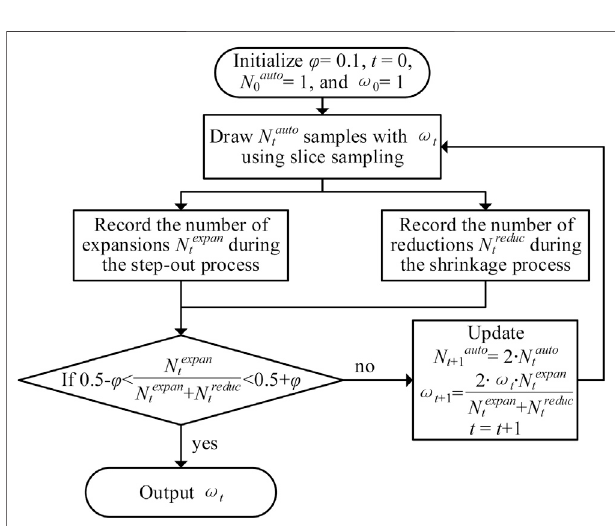
FIGURE 6 | Flow chart of the step width